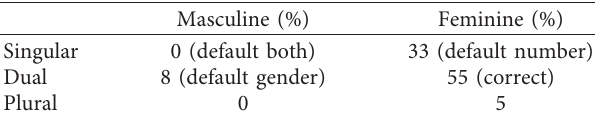
Table 5: Adjective number and gender responses (target noun is